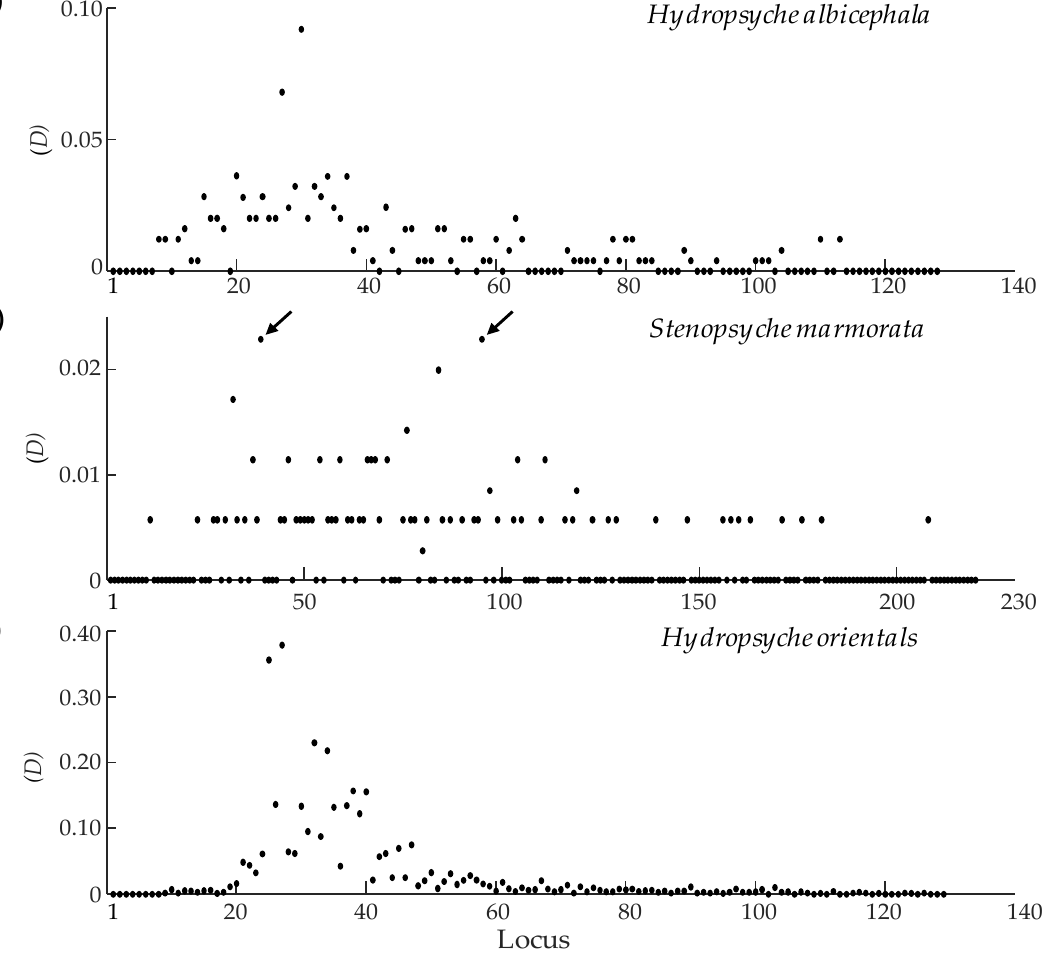
Figure 5. Cluster distance ( D ) in the order of loci presence (rank on x axis) after recognition in Hydropsyche albicephala ( a ); Stenopsyche marmorata ( b ); and Hydropsyche orientals ( c ).